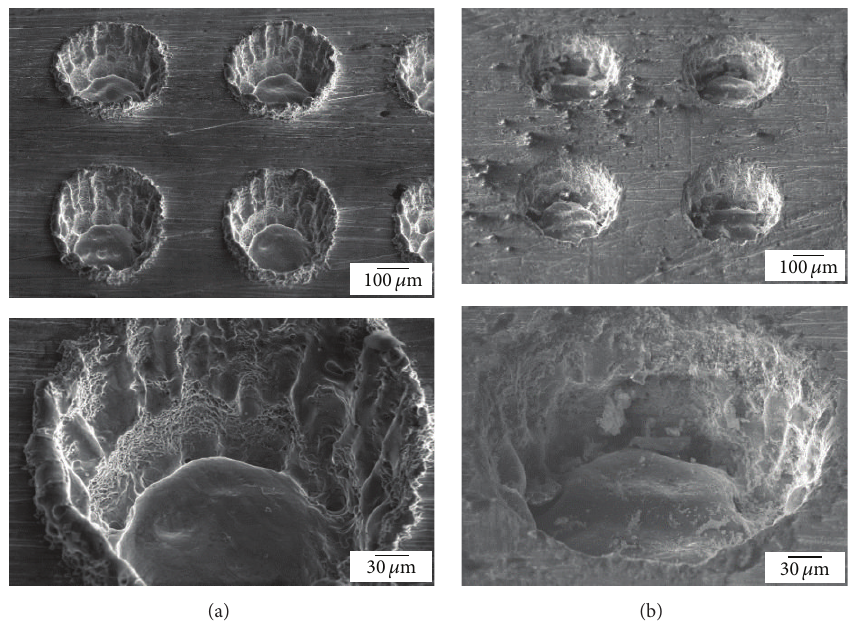
Figure 17: SEM images of die radius—texture #5: (a) before and (b) after hot stamping tests.